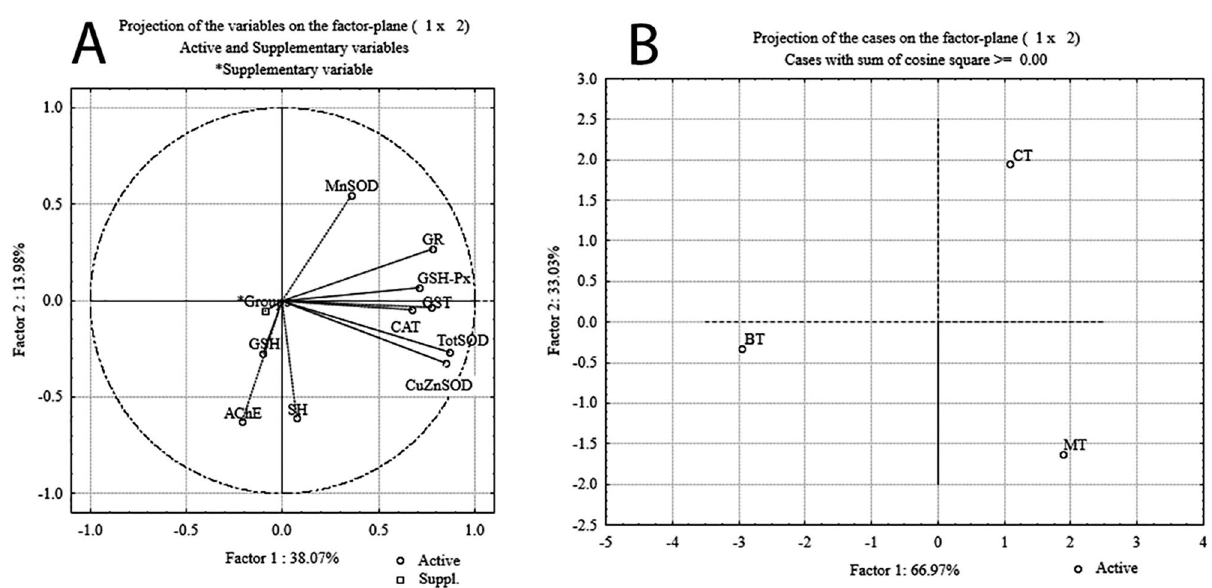
Figure 1. Principal Component Analysis (PCA): ( A )-projection of the relative contribution of every antioxidant component; ( B )-projection of groups based on antioxidant defense parameters.